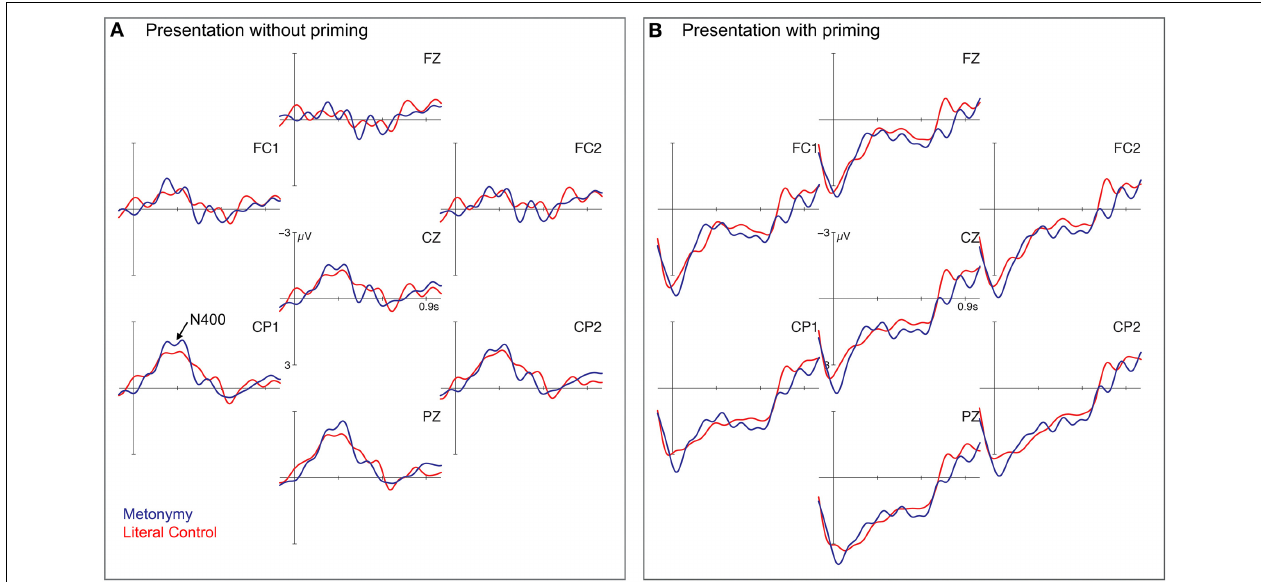
FIGURE 5 | GrandaverageERPsforExperiment2aand2b. GrandaverageERPsat7selectedelectrodesformetonymic(blue)andliteral(red)conditionswithout priming in (A) (Experiment 1a) and with priming in (B) (Experiment 1b). Vertical bar represents the word recognition point of the target; negativity is plotted